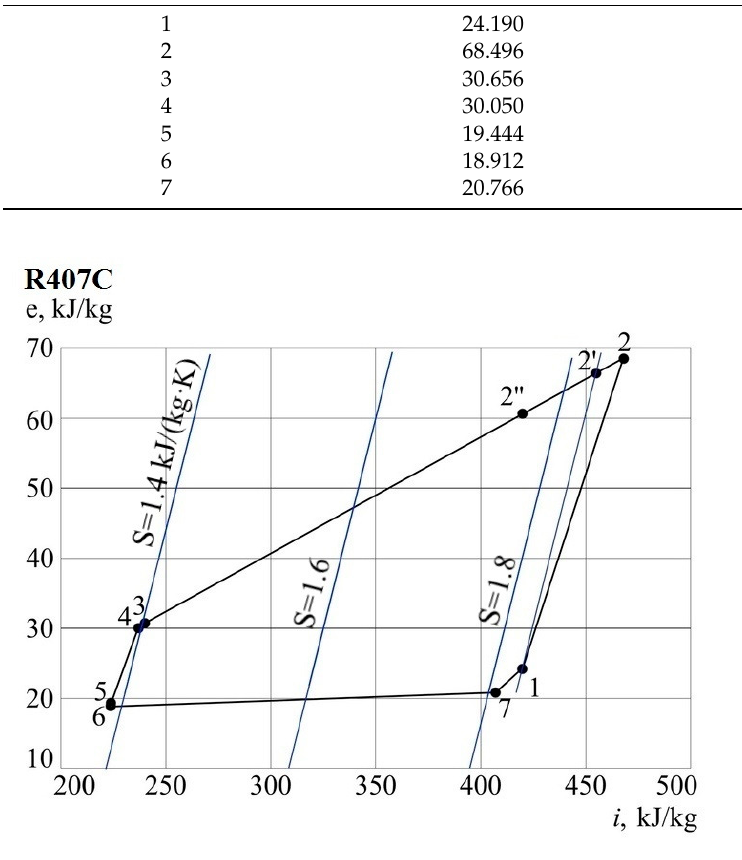
Figure 8. The cycle of the heat pump plant in e-i